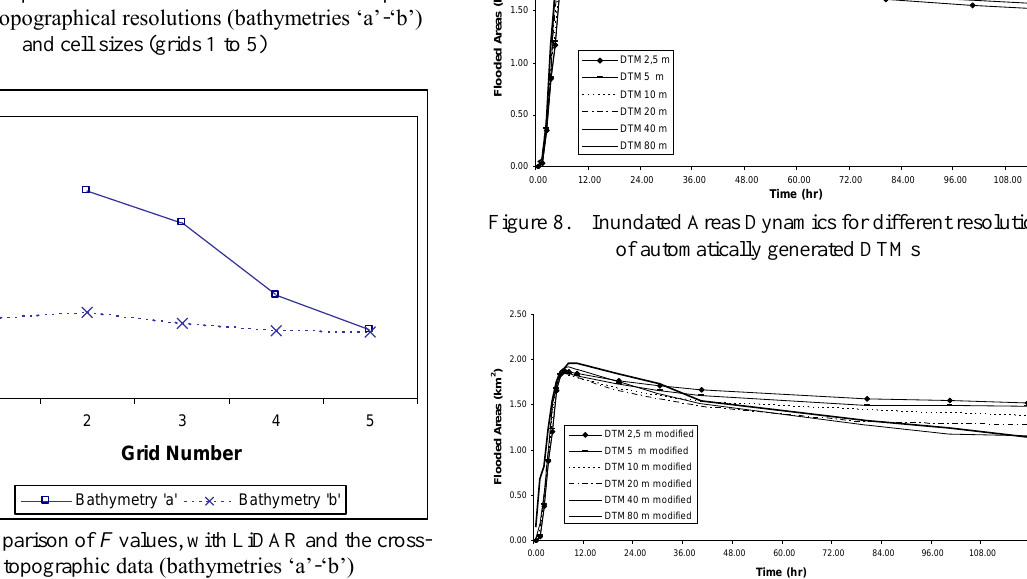
Figure 9. Inundated areas dynamics for modified